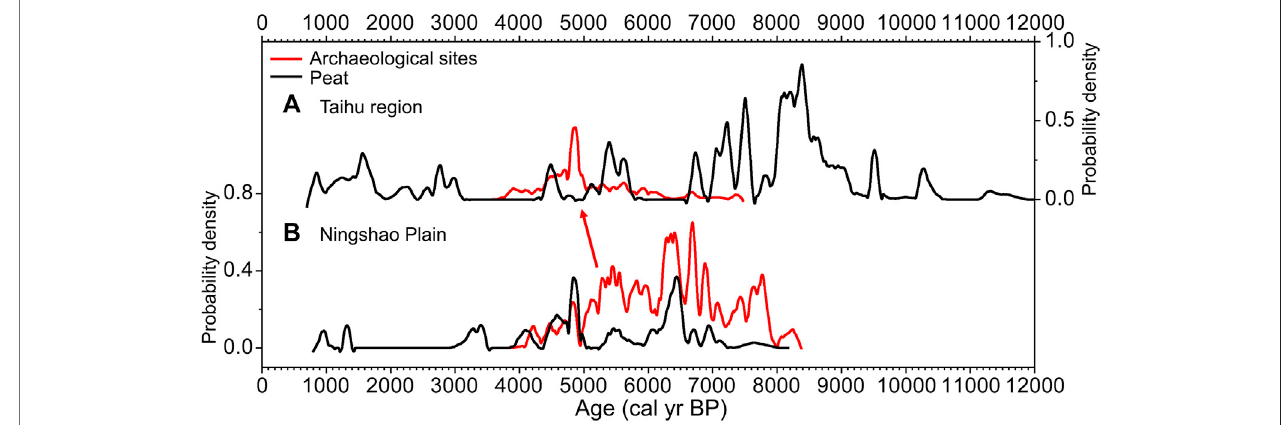
FIGURE 7 | Comparison between the SPD of radiocarbon dates of archaeological sites and peat in the Ningshao Plain and the Taihu region. (A) Taihu region. (B) Ningshao Plain. All these are 200-point-smoothing results. Red arrow indicates the shift of demographic centers.